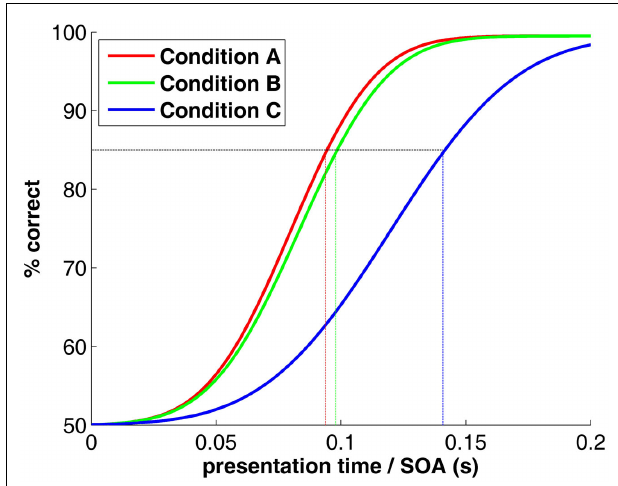
FIGURE 1 | Psychometric functions (hypothetical) for a typical RSVP or masking experiment. The x -axis would represent presentation time of each image in the sequence, or stimulus-mask SOA (respectively).The natural tendency to read from this graph that processes A and B have similar speeds whereas process C is 50ms slower is inaccurate. See text for